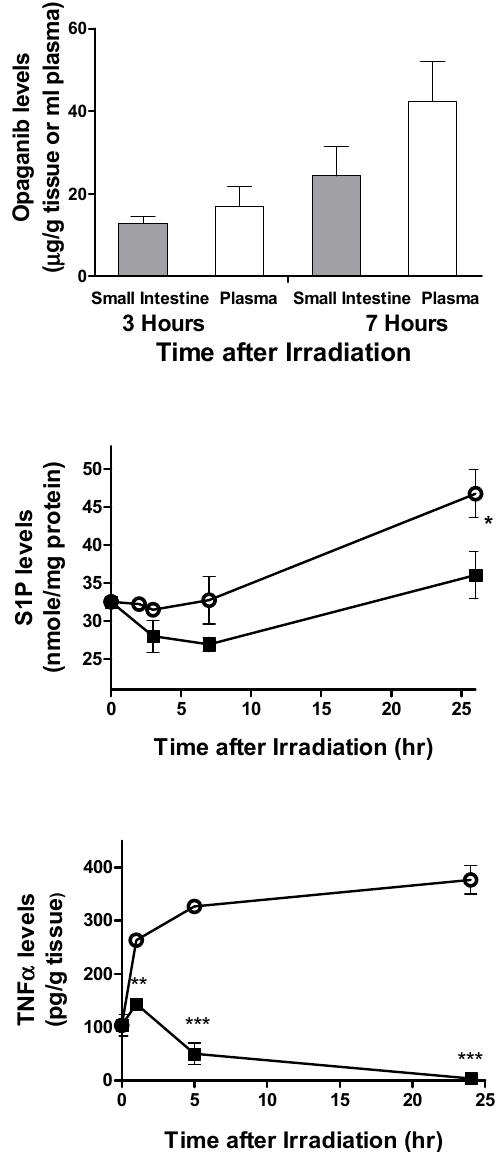
Figure 2. Biodistribution and pharmacodynamics of opaganib in the small intestine. Top Panel : Mice were treated with opaganib (100 mg/kg) orally and sacrificed at either 3 or 7 h. Plasma and extracts from the small intestines were analyzed for opaganib concentrations as described in the Materials and Methods section. Middle and Bottom Panels: Mice were treated with 0 ( ○ ) or 100 ( ∎ ) mg/kg opaganib orally 2 h before exposure to 9.5 Gy radiation and then sacrificed at the indicated times for evaluation of TNF α and S1P levels in the small intestine ( n = 3–5 mice per time point; * p < 0.05, ** p < 0.01, *** p < 0.001.).